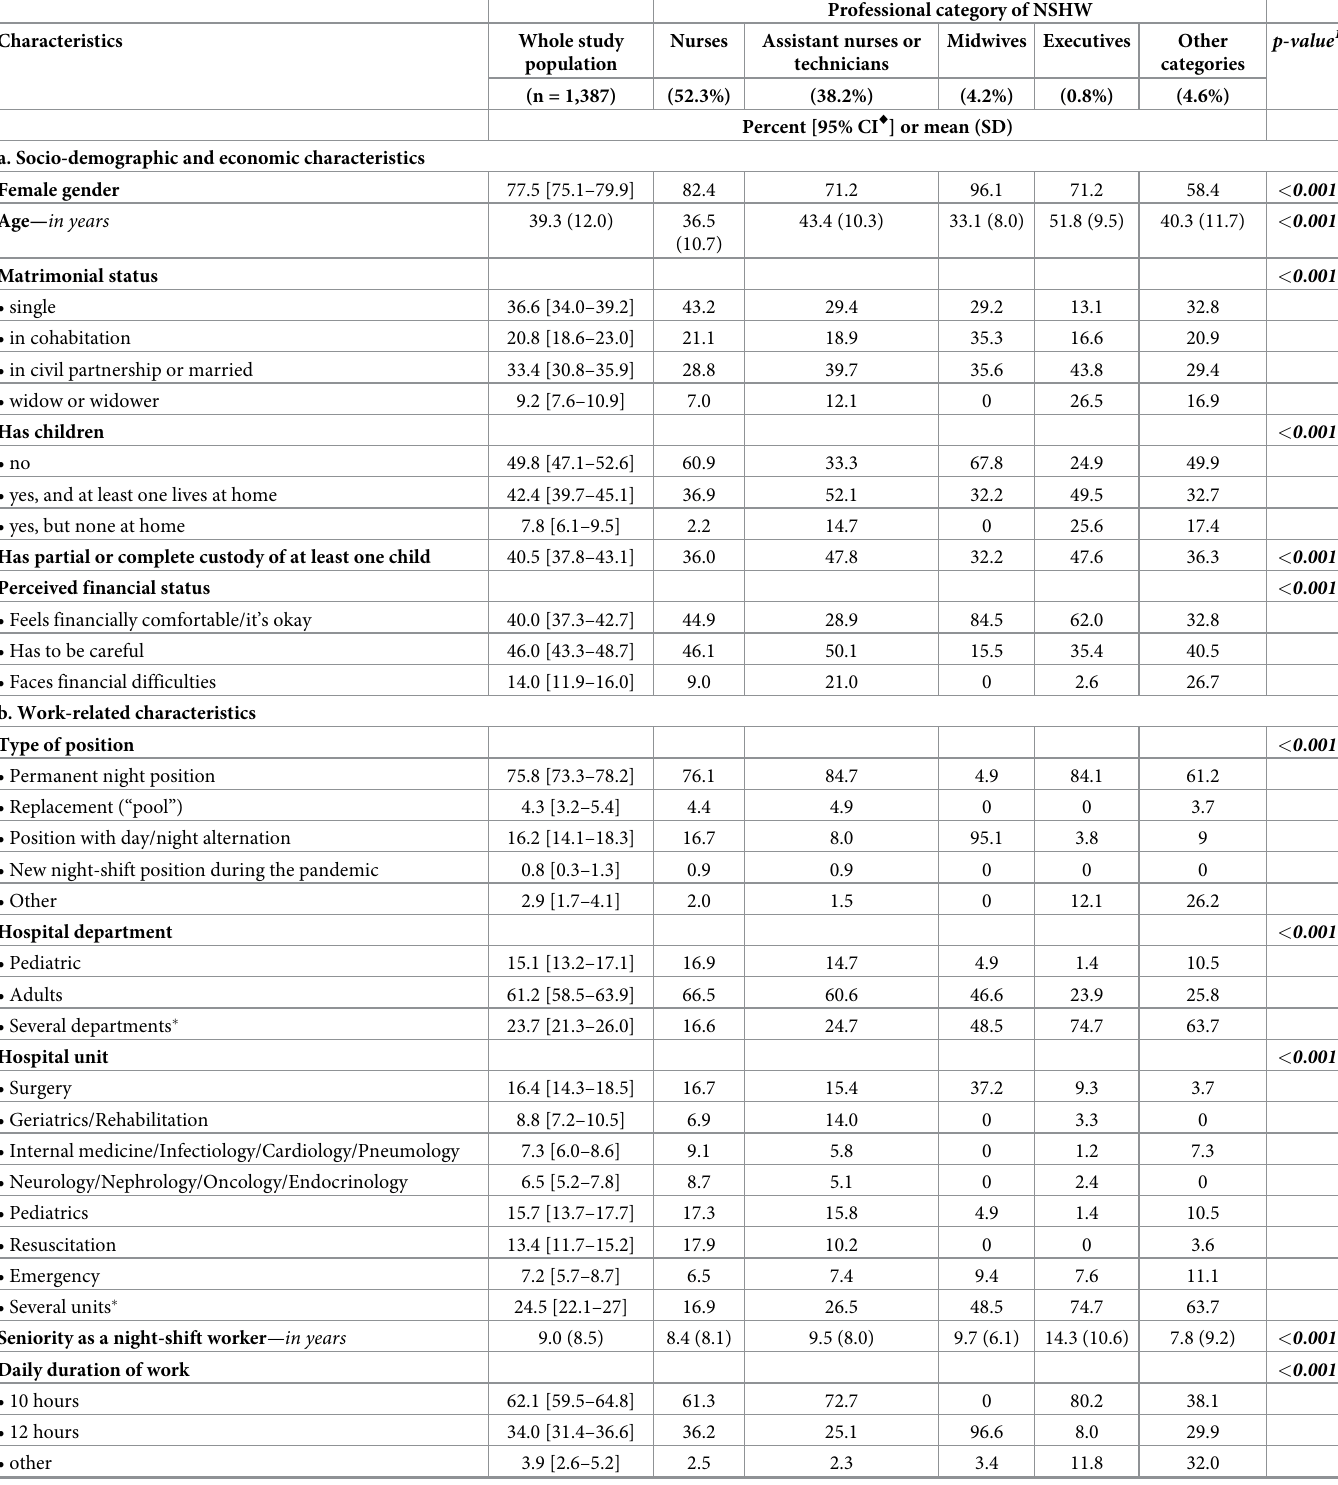
Table 1. Main characteristics of night-shift healthcare workers according to their professional category (n = 1,387, AP-HP ALADDIN survey, Paris public